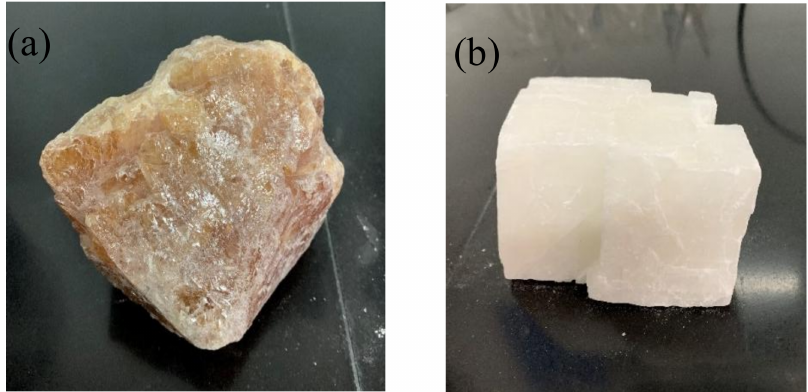
Figure 1. The images of pure scheelite ( a ) and calcite ( b ).